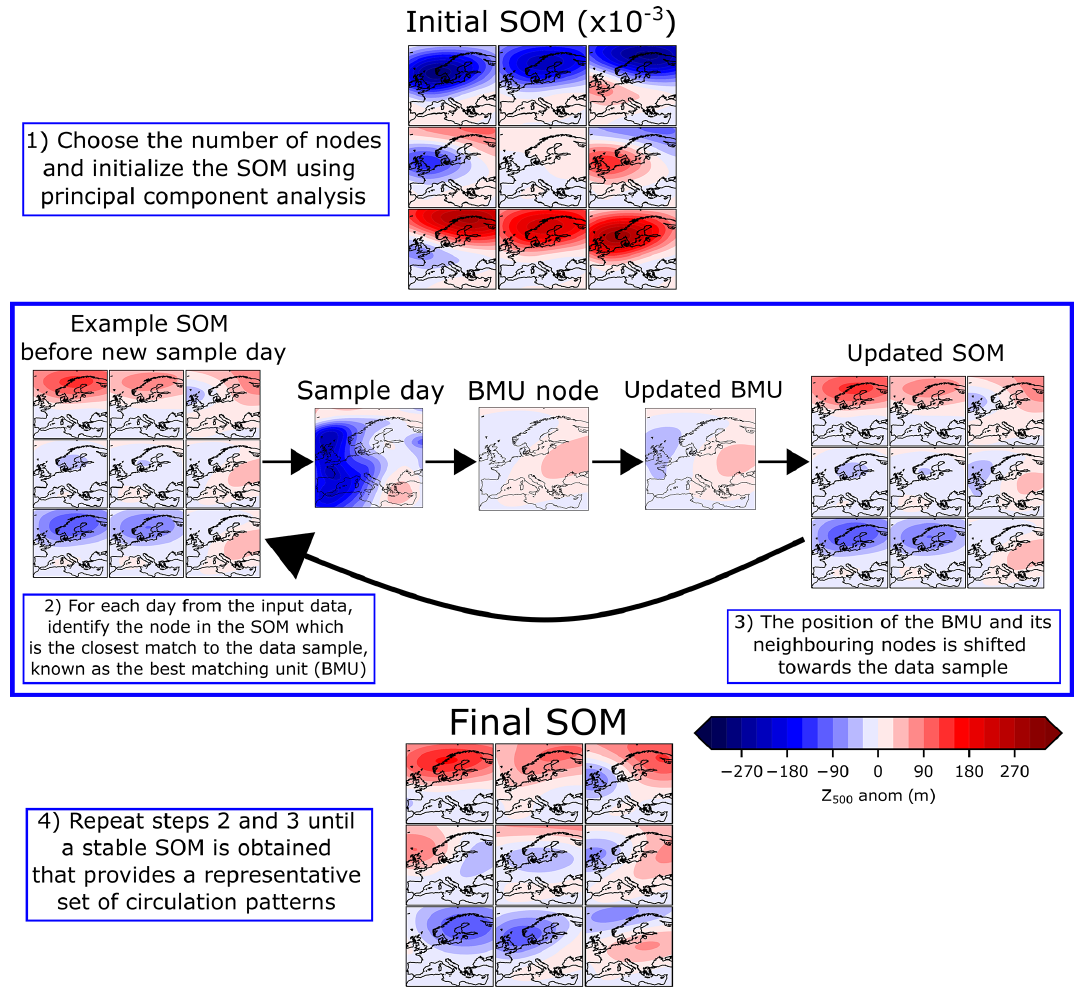
Figure 2. The self-organizing map algorithm. Shown using a 3 × 3 node SOM with ERA5 Z 500 JJA 1979–2019. The principal component analysis (PCA)-initialized SOM pattern (step 1) has a much larger amplitude so it has been multiplied by 10 − 3 for visualization purposes. The BMU refers to the best-matching unit, the SOM node which most closely matches the sample